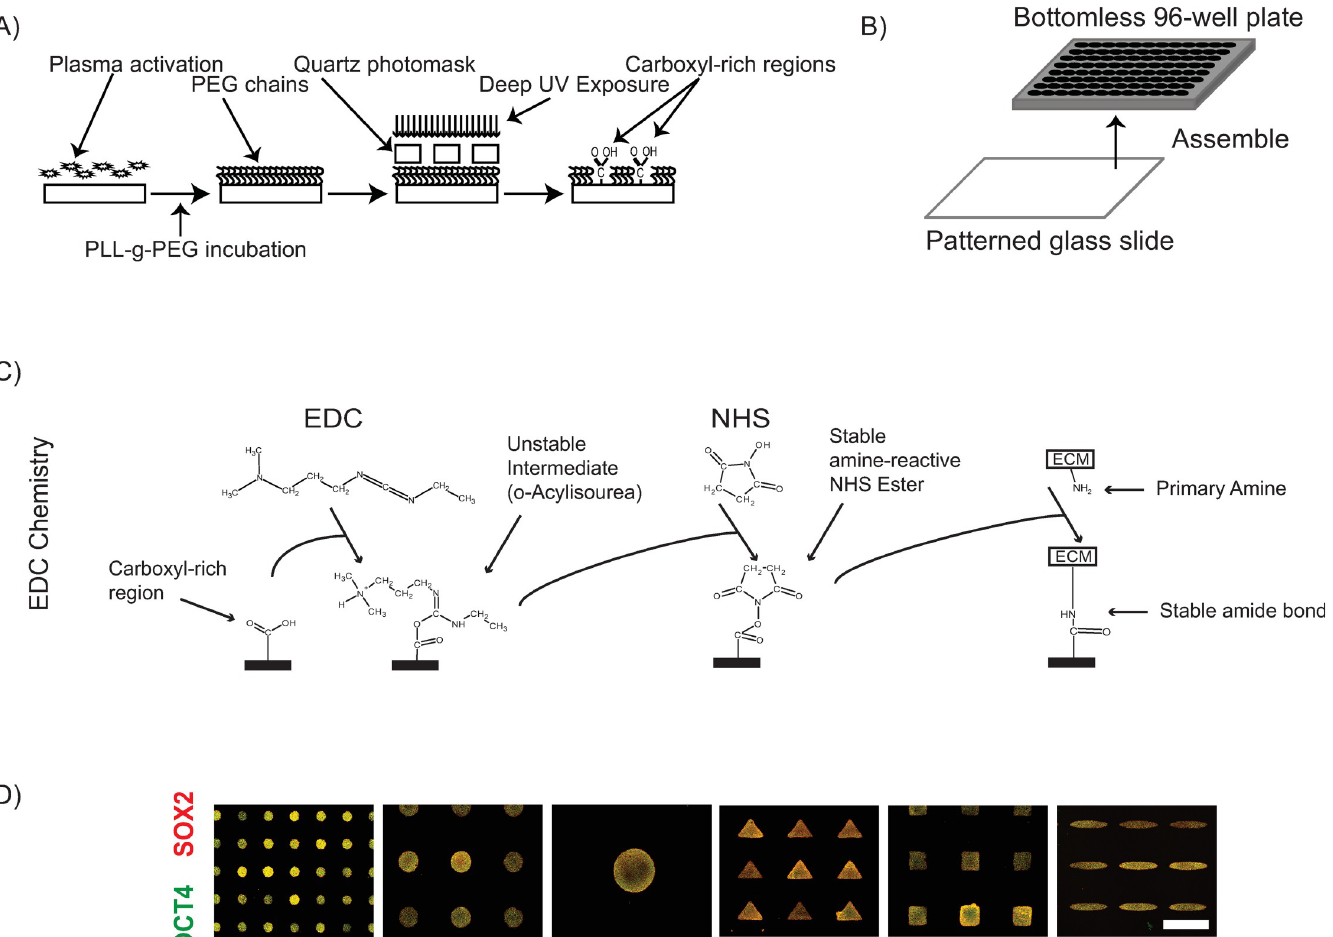
Fig 1. Development of PEG based micropatterning platform. (A) Scheme of protocol for transferring carboxyl-rich micro-patterns onto glass coverslips. (B) Overview of assembly procedure to produce 96-well microtiter plates with micropatterned culture surface. (C) Overview of carbodiimide- and succinimide-based ECM protein immobilization scheme. The carboxyl groups induced on the patterned glass coverslips react with EDC to form an unstable intermediate molecule O-Acylisourea. If kept in an aqueous environment for an extended period of time, this activated state may hydrolyze and result in the loss of activation of the carboxyl group. O-Acylisourea reacts with the present NHS molecules to form a stable amine-reactive NHS ester. This activated state is stable when kept dry, and the plates can be stored dry for some time after this activation step. Upon incubation with proteins (for instance, ECM proteins), it results in a covalent immobilization of the protein to the substrate. (D) Representative immunofluorescent images of micropatterned hPSCs colonies generated using the protocol depicted in panels A through C stained for OCT4 and SOX2. ECM, extracellular matrix; EDC, 1-Ethyl-3-(3-dimethylaminopropyl)carbodiimide; NHS, N-HydroxySuccinimide; OCT4, octamer-binding transcription factor 4 (also known as POU5F1); PEG, Polyethylene Glycol; PLL-g-PEG, Poly-L-Lysine-grafted-Polyethylene Glycol.